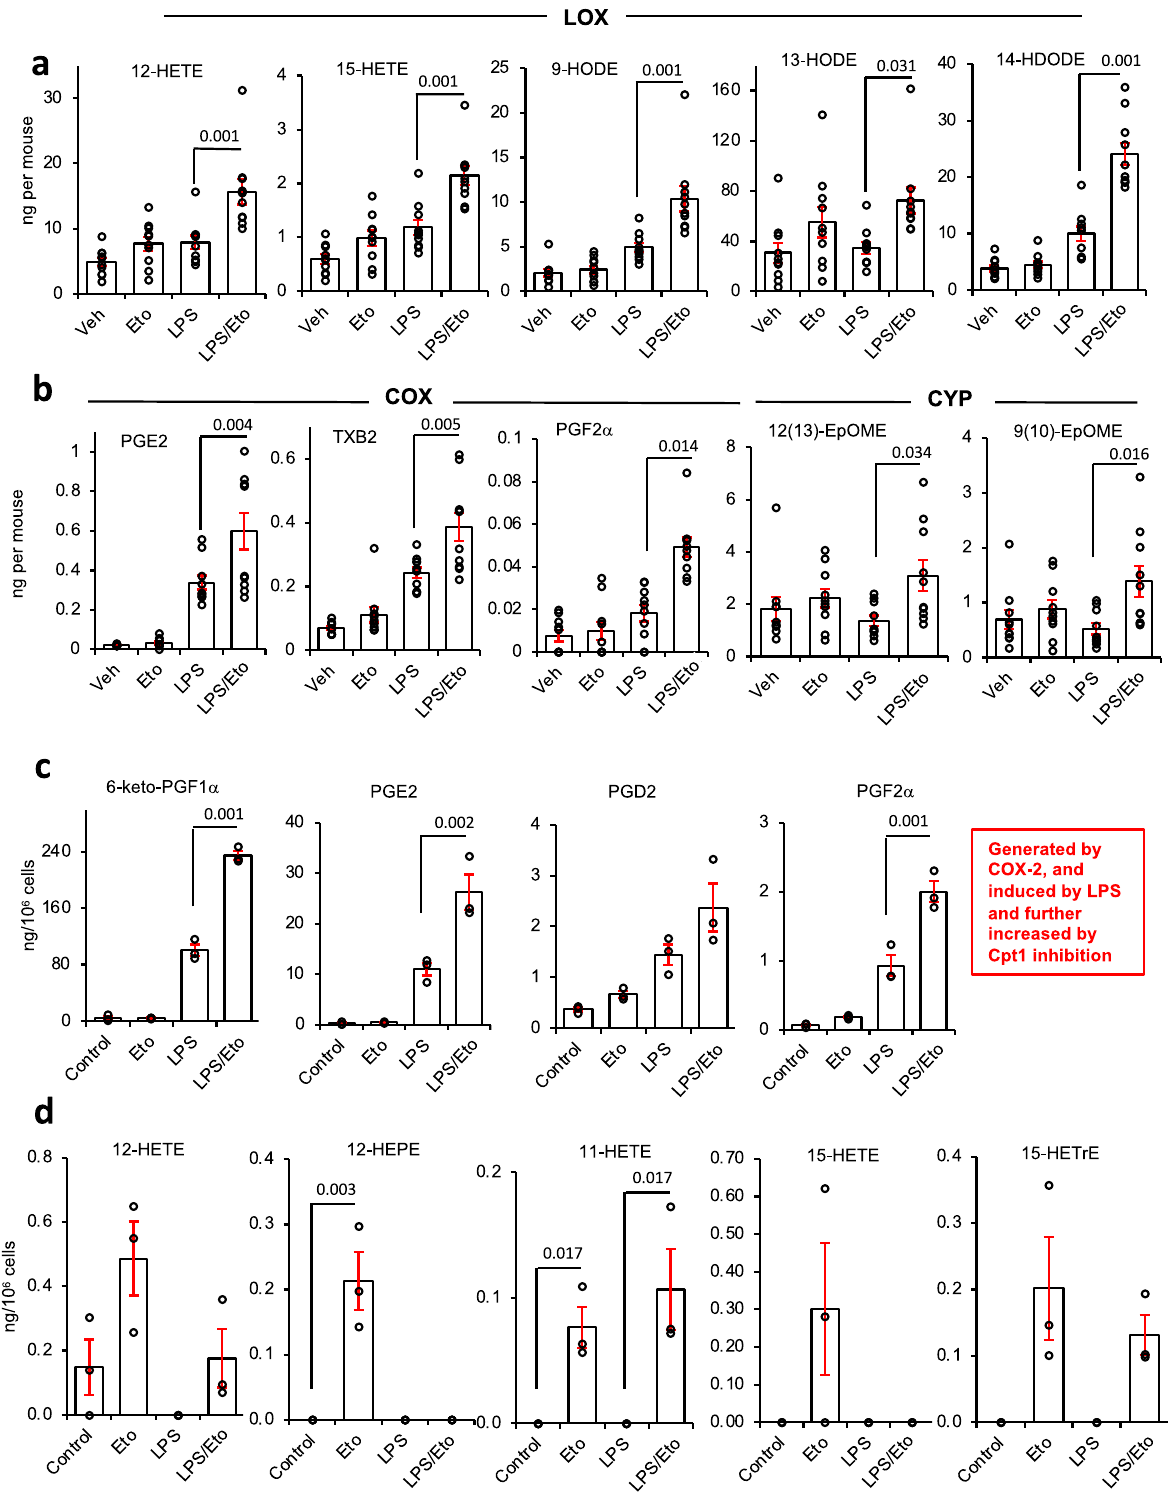
derived lipids show the opposite, where CPT1 inhibition dampens levels. Bone marrow-derived macrophages (BMDM) consume diverse oxylipins from serum . Macrophages are exposed to